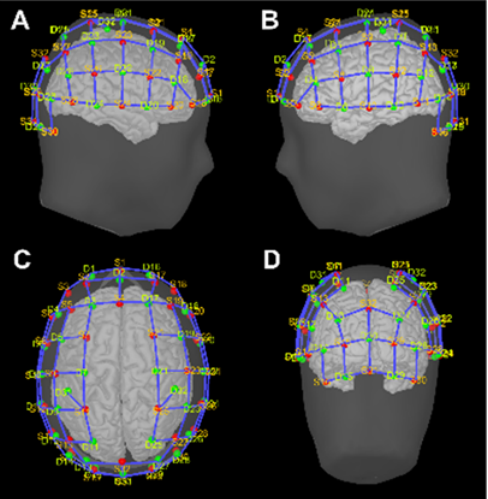
Figure 1. ( A – D ) Graphical representation of NIRS source (S, red dots) and detector (D, green dots) positioning over scalp surface (( A )—right hemisphere view; ( B )—left hemisphere view; ( C )—superior view; ( D )—occipital view).